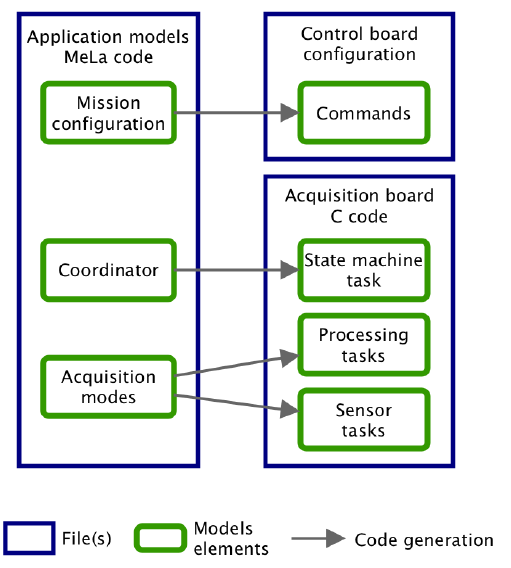
Figure 5. Code generation